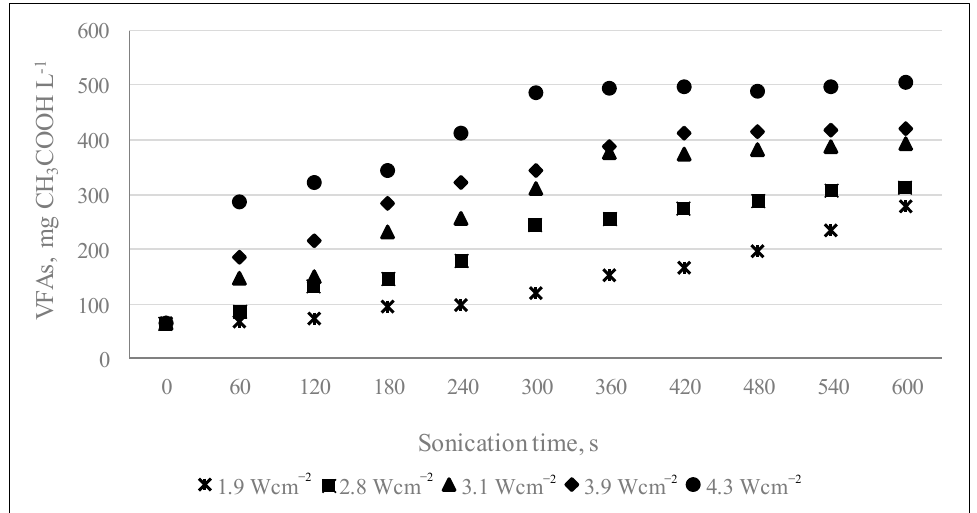
Figure 2. Changes of the VFAs concentration value in the ultrasonic disintegration process for the tested ultrasound field intensity values depending on the sonication time.